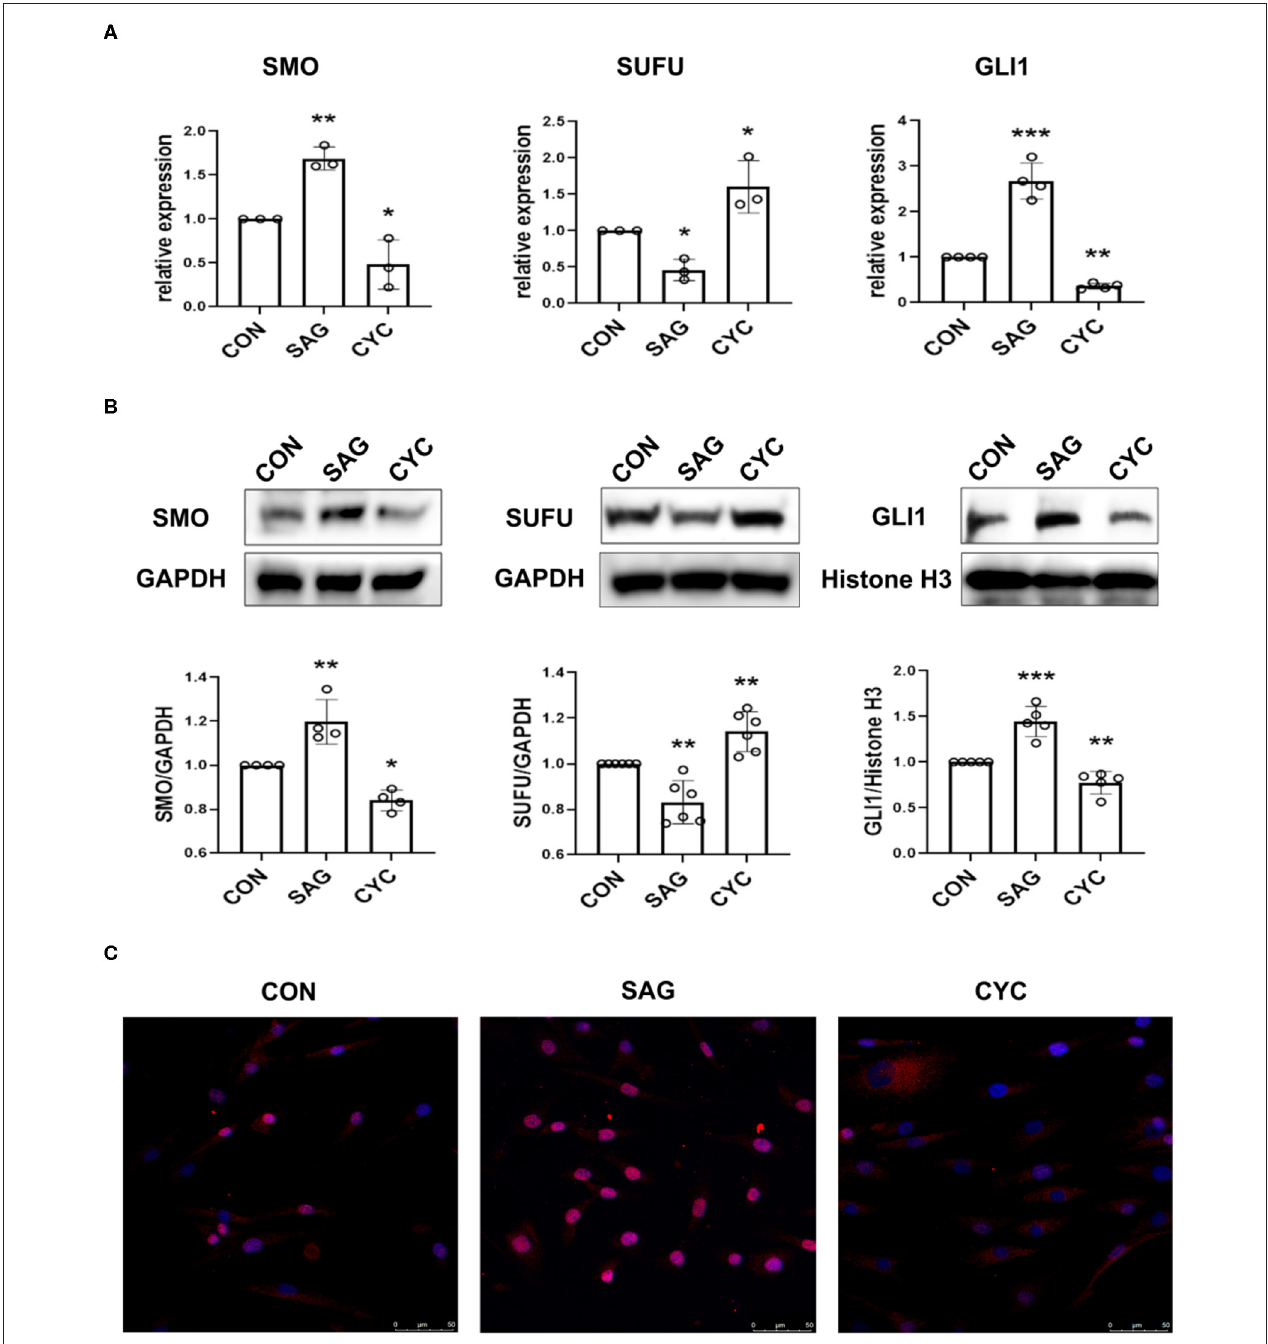
FIGURE 1 | SAG and cyclopamine modulate the activation of SHH signaling. (A) SMO, SUFU and GLI1 mRNA expression was evaluated by real-time PCR after FLSs were treated with SAG (1 µ M) or cyclopamine (10 µ M) for 24h. Relative quantification of gene expression was performed by the 2 − 11 Ct method. (B) The expression of SMO, SUFU and GLI1 was measured by Western Blot after FLSs were treated with SAG (1 µ M) or cyclopamine (10 µ M) for 48h. Total protein was isolated for detection of SMO and SUFU and nuclear extracts were prepared for detection of GLI1. Results were normalized to loading control (GAPDH for total protein and Histone H3 for nuclear extracts). The results are shown as the mean ± S.D. (C) The distribution of GLI1 protein was measured by immunofluorescence ( n = 3). FLSs were treated with SAG or cyclopamine for 48h and stained with anti-GLI1 antibody (red signal) and DAPI (blue signal). Representative images are shown at 200 × magnification. FLSs in control group were treated with vehicle (DMSO supplemented in DMEM with 10% FBS). Data were analyzed using one-way analysis of variance (ANOVA). post hoc comparisons were made by Dunnett’s test (A,B) . * P < 0.05 vs. control group. ** P < 0.01 vs. control group. *** P < 0.001 vs. control group. CON, control group; CYC, cyclopamine; SP,